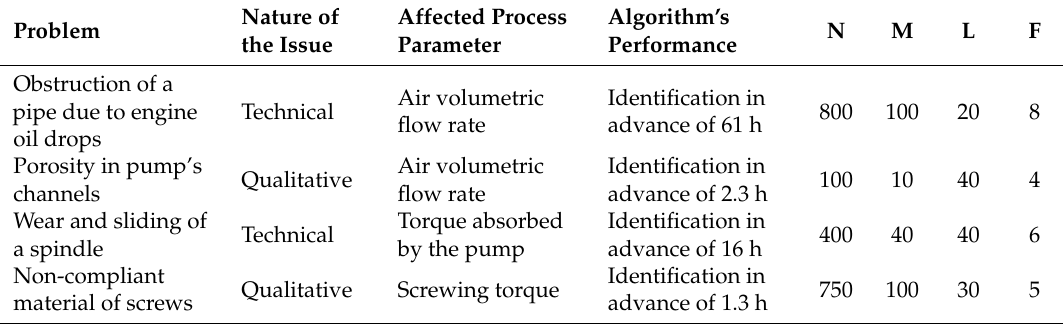
Table 3. Advance achievable with proposed tool with respect to original warning systems on both technical and qualitative